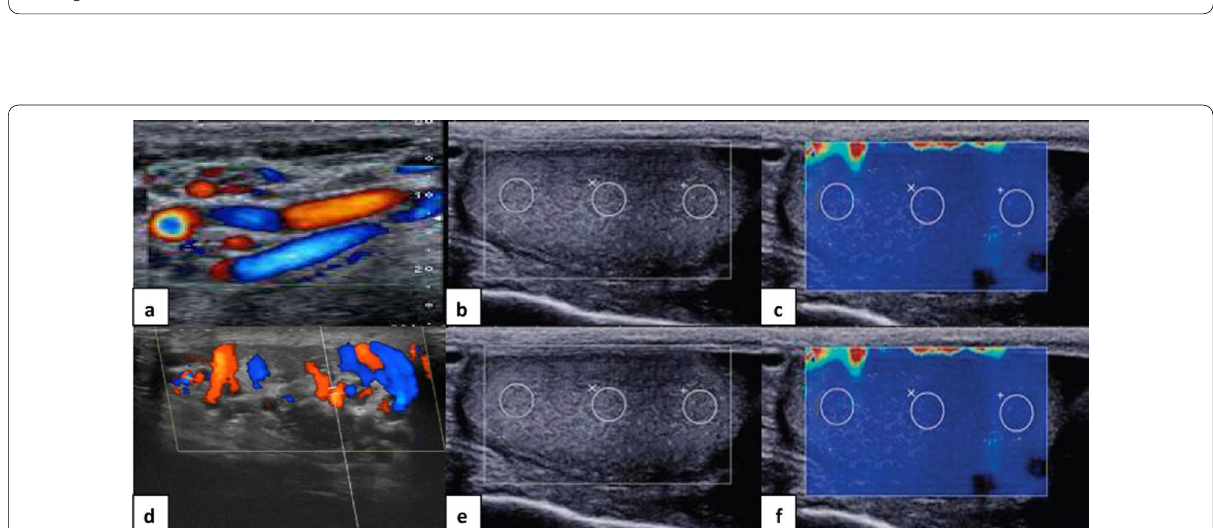
Fig. 3 A 28-year-old patient with bilateral testicular varicocele and normal total sperm count. a Rt. testicular high-resolution ultrasound showed testicular varicocele (grade I). b , c Shear wave elastography of the Rt. testicle displayed homogenous blue color and increased mean testicular stiffness value 4.9 kPa. d Lt. testicular high-resolution ultrasound showed testicular varicocele (grade III). e , f Shear wave elastography of the Lt. = testicle displayed homogenous blue color and increased mean testicular stiffness value